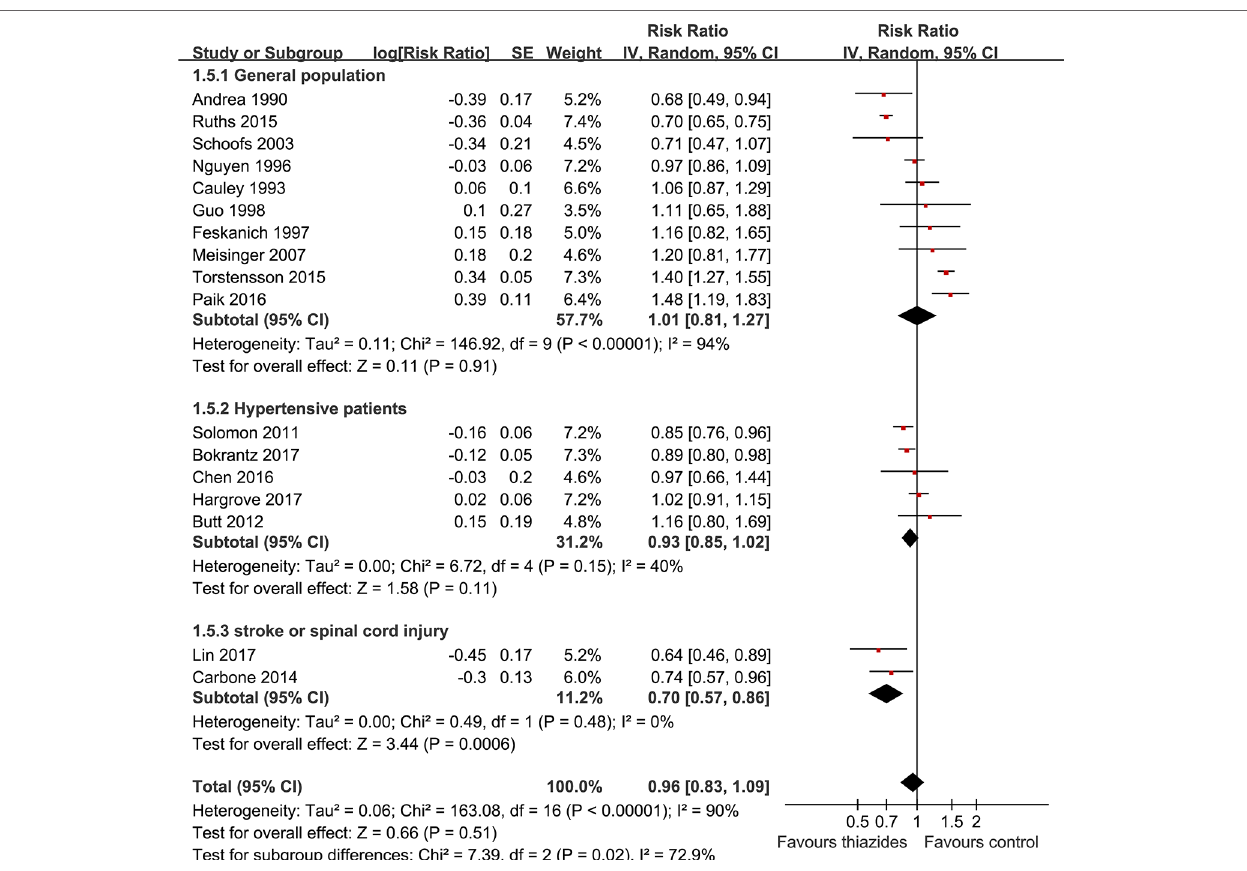
FIGURe 3 | Subgroup analyses for the association between the use of thiazide diuretics and the incidence of fracture by sources of the participants.